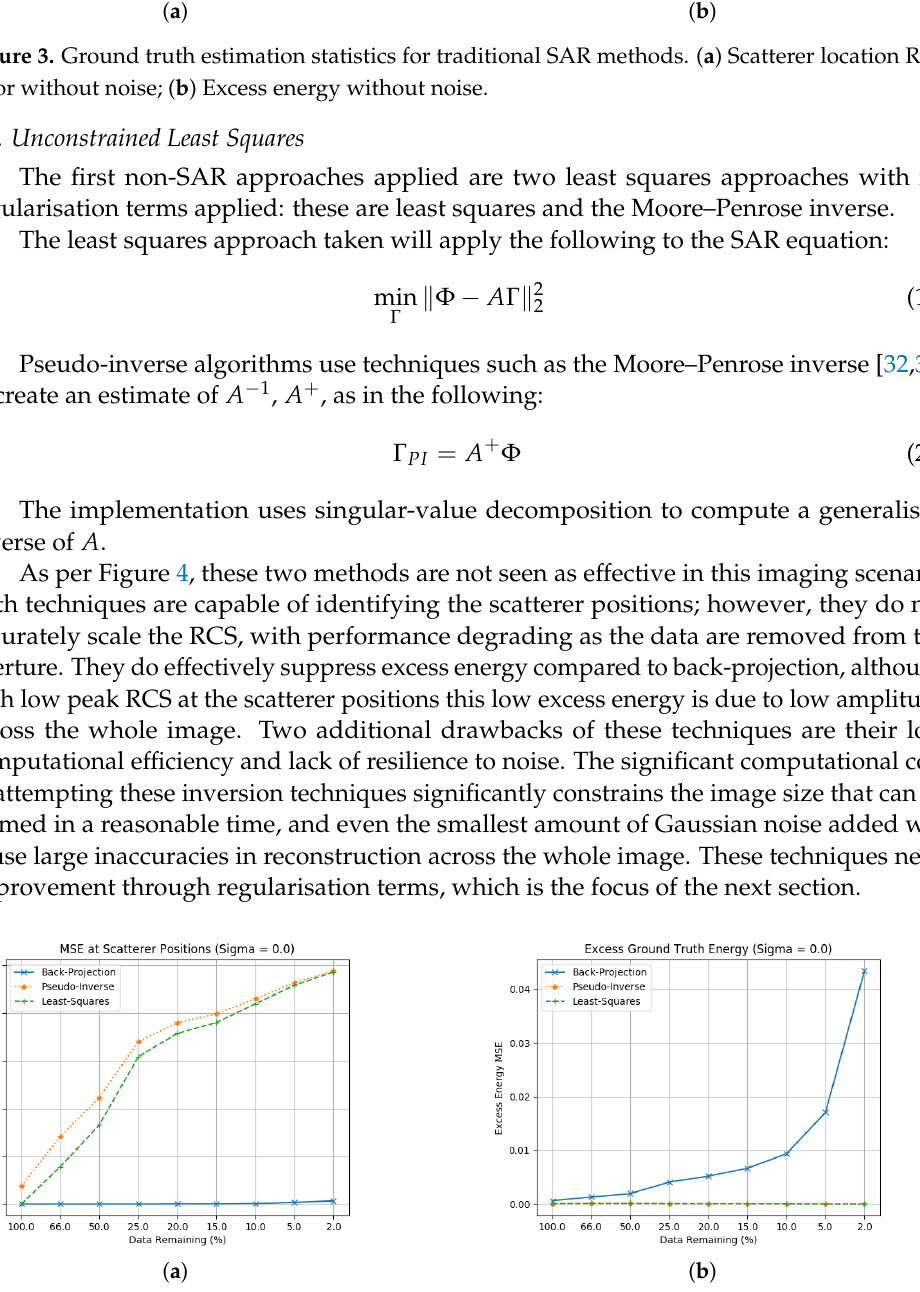
Figure 4. Ground truth estimation statistics for unconstrained least squares methods. ( a ) Scatterer location RCS error without noise; ( b ) Excess energy without